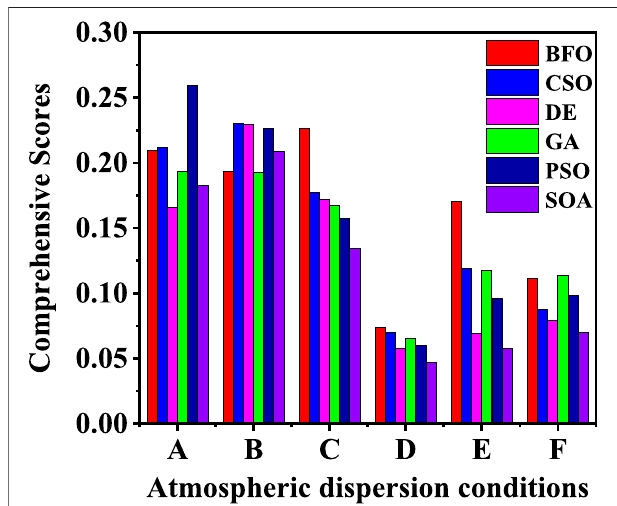
FIGURE6| ComprehensivescoresoftheBIOsforallsourceparameters (Q 0 , x 0 , y 0 , z 0 ) under different atmospheric dispersion conditions (stability classes (A –